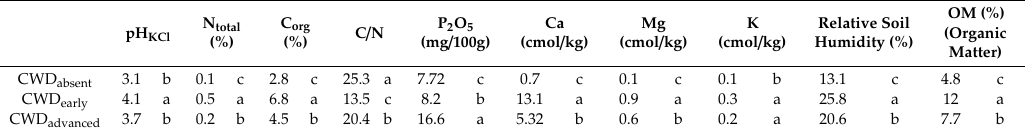
Table 2. Mean values of selected physical and chemical properties of soils in the study sites ( n = 10), with di ff erent conditions of coarse woody debris (absence of coarse woody debris (CWD absent )) and early (CWD early ) and advanced (CWD advanced ) stages of decomposition. Di ff erent letters indicate significant di ff erences between values in columns.